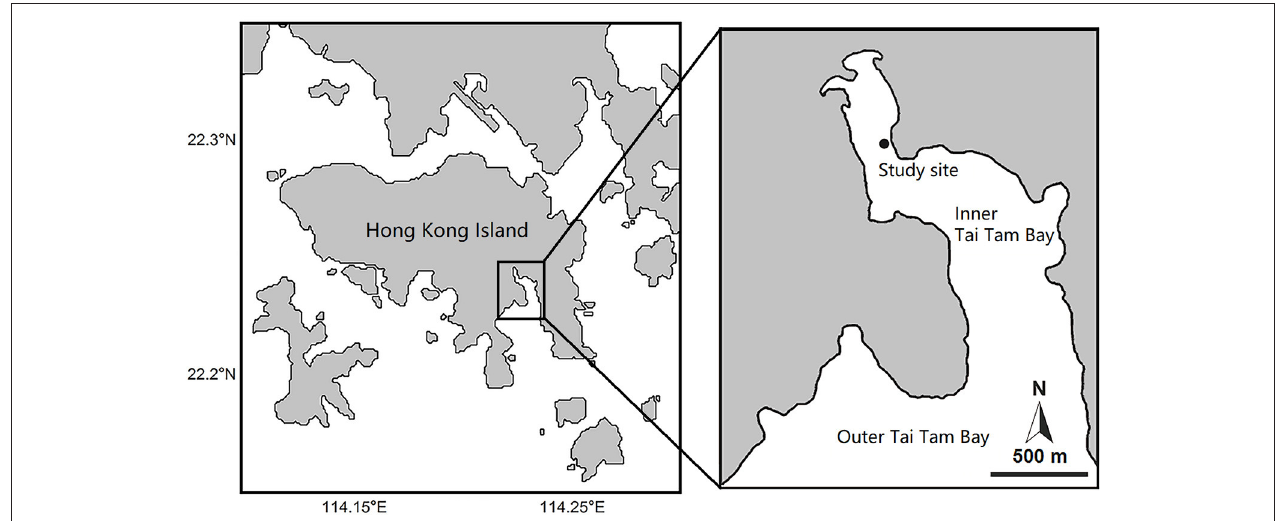
FIGURE 1 | The study site at inner Tai Tam Bay on the southern coast of Hong Kong Island, Hong Kong SAR,